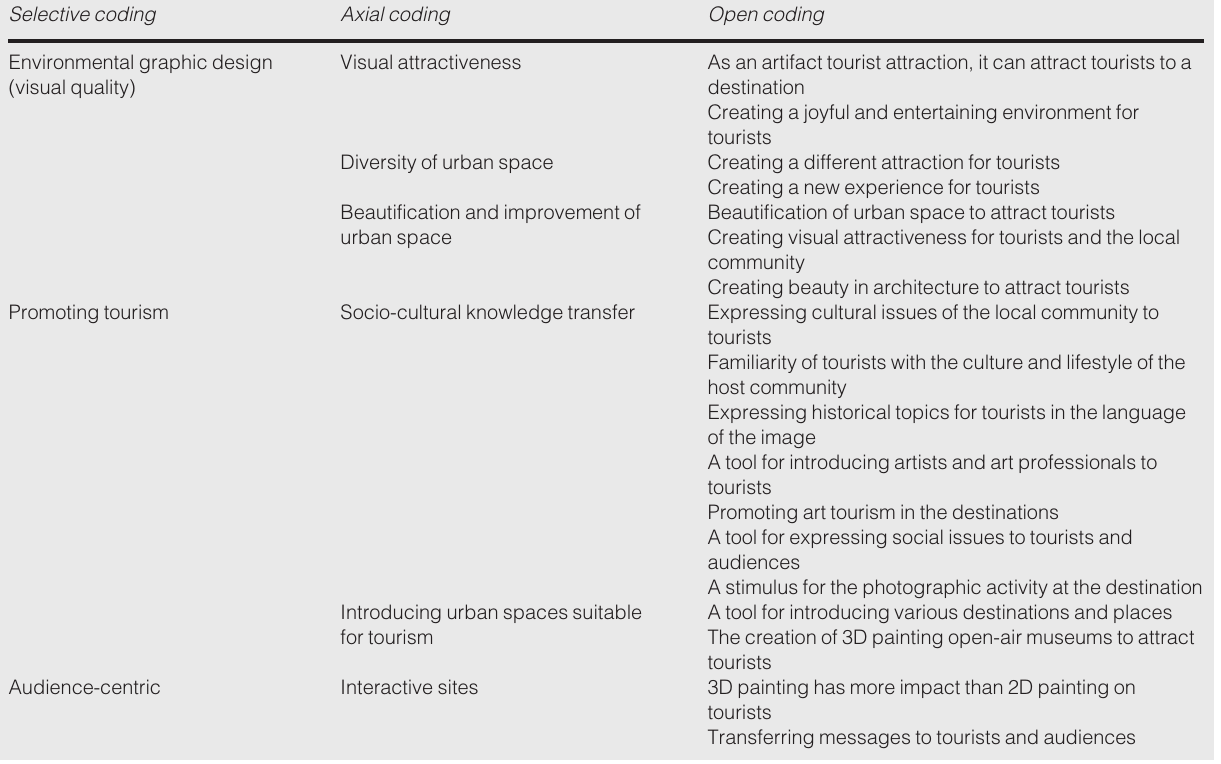
Table 1 Qualitative method (open, axial and selective coding) to investigate how trompe l ’ oeil can promote art tourism